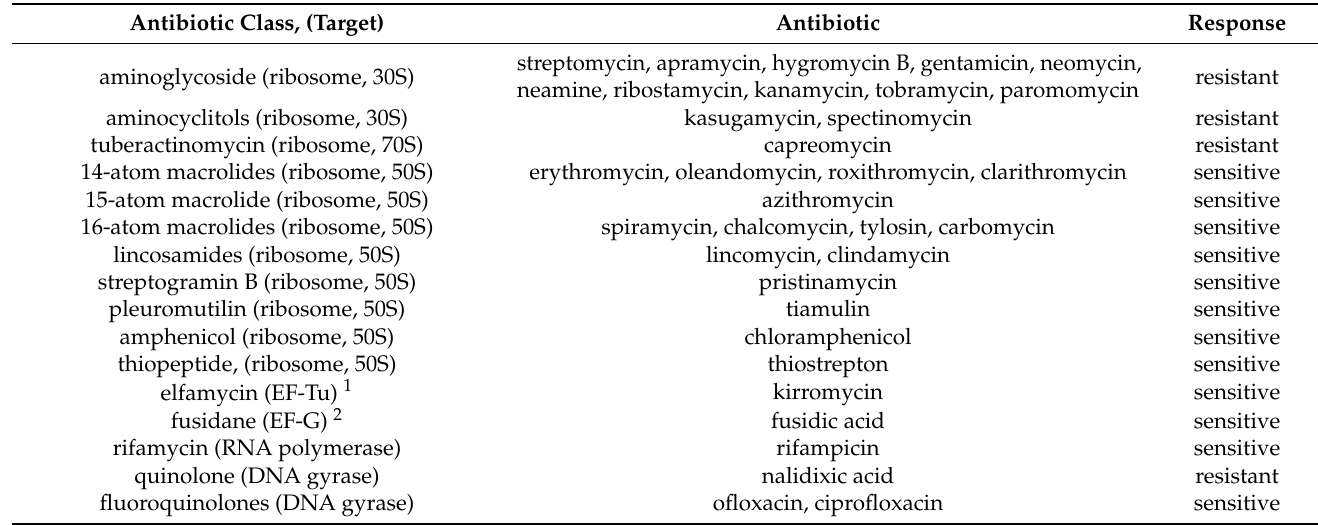
Table 1. Antibiotic sensitivity spectrum of R. marinus R-10 T . Sensitivity was assessed using a disc assay to measure zones of